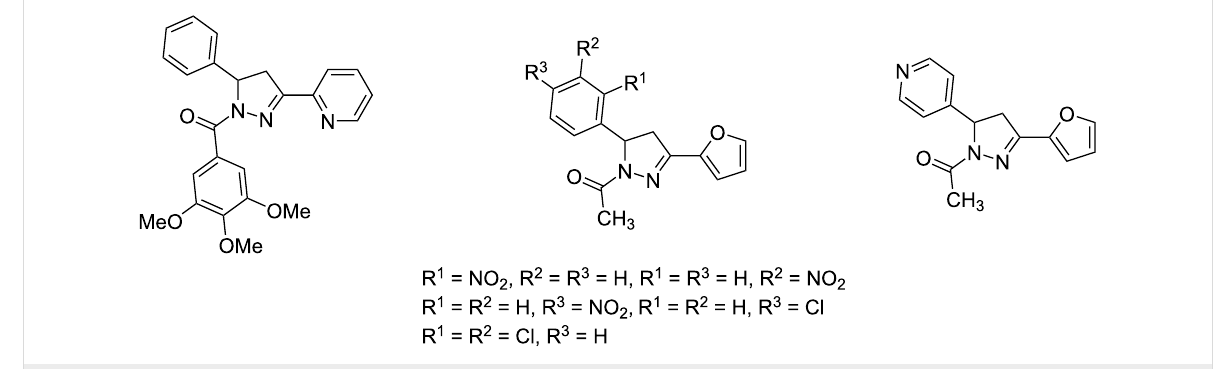
Figure 1: Selected anticancer active 3,5-diaryl-1-acylpyrazoline (left) and xanthine oxygenase inhibitors (center and right).